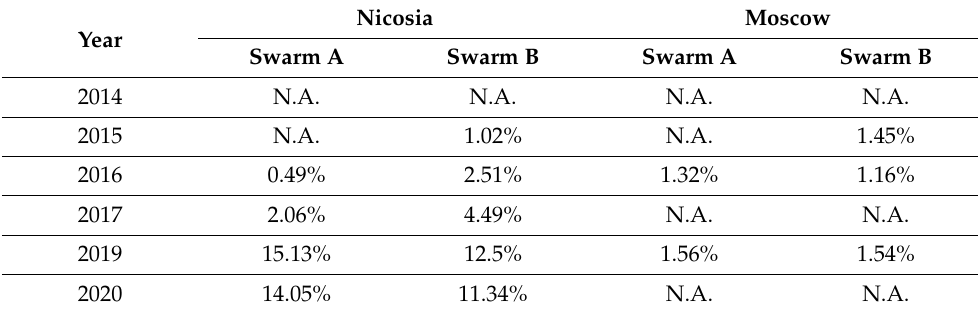
Table 1. Percentage of observations for Ne/NmF2 ≥ 1 over Nicosia and